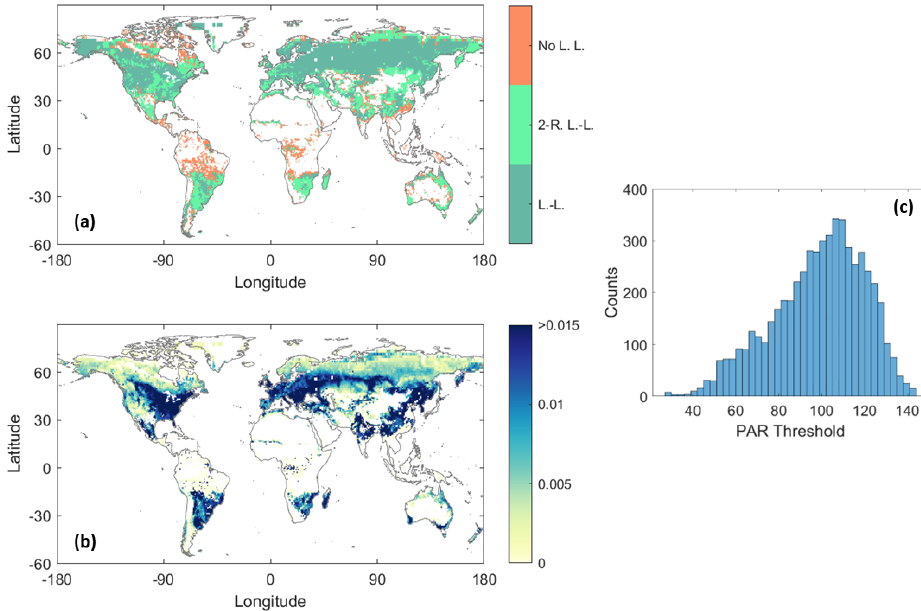
Figure 7. Estimated SIF–photosynthetically active radiation (PAR) relationship features. (a) Model type (L.-L.: light-limited; 2-R. L.-L.: two- regime light-limited; No L. L.: no light limitation), (b) model slope (10 − 3 nm − 1 sr − 1 ) in the light-limited regime, and (c) model threshold (Wm − 2 ) for the SIF–PAR relationship. White shading denotes areas where the SIF–PAR correlation is not positive – i.e., where SIF is not increasing with PAR – or areas where no collocated SIF and PAR records are